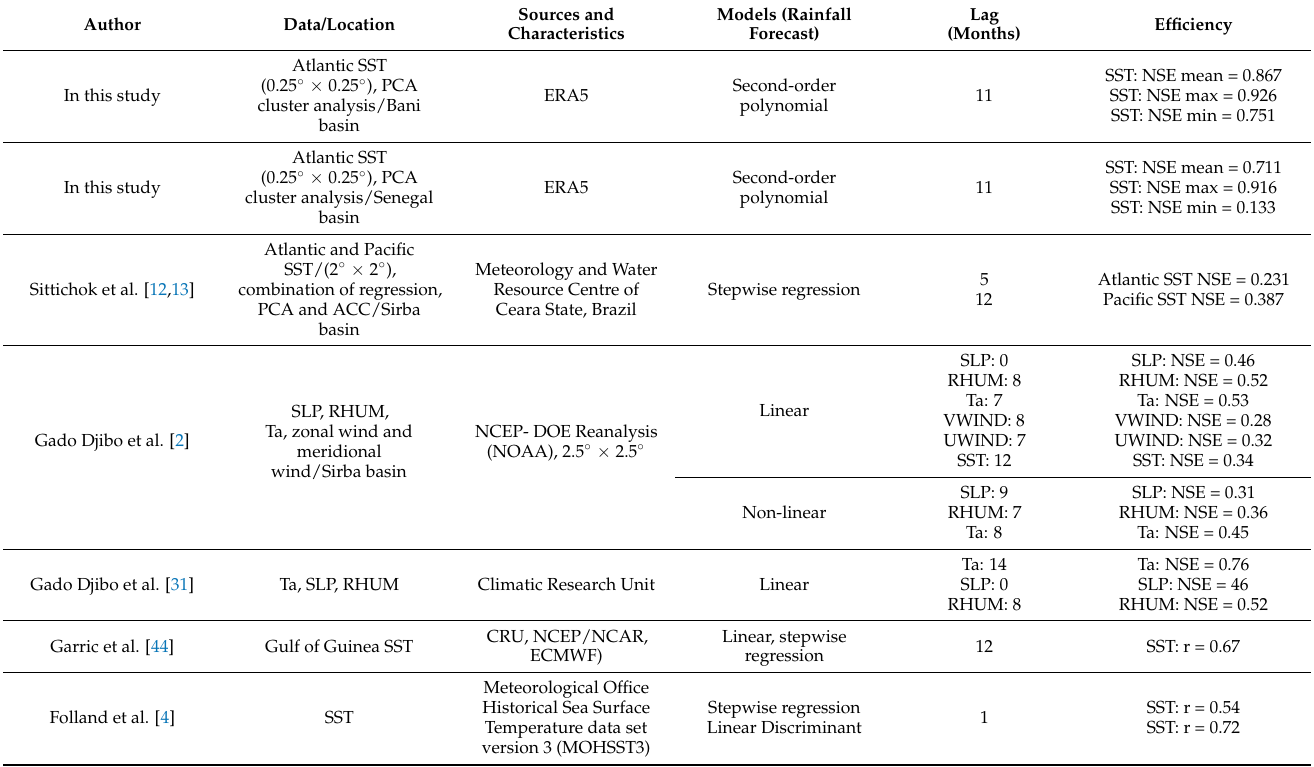
Table 5. Comparison of results of the precipitation forecast models of this study with previous